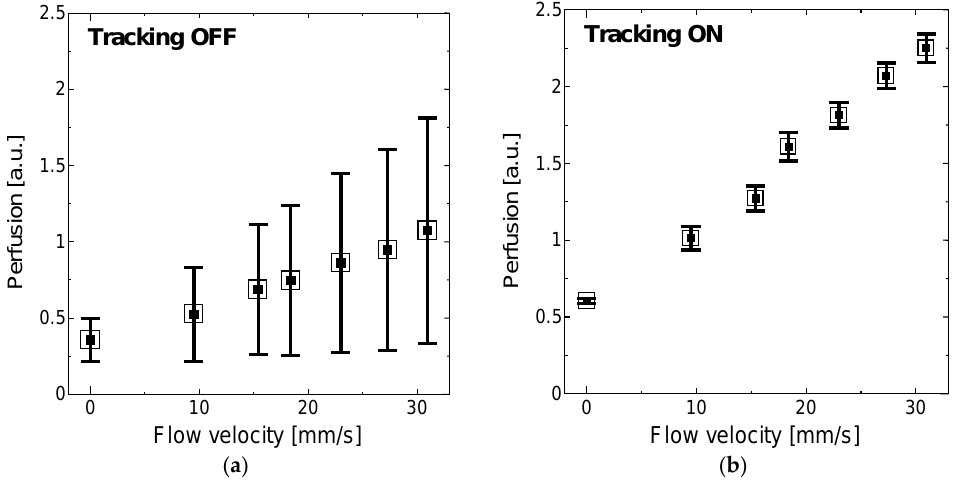
Figure 11. Perfusion value (mean and standard deviation over 20 s) for different flow velocities ranging from 0 to 31 mm/s ( a ) without tracking engaged; and ( b ) with tracking. The standard deviation is correlated with motion artifacts.